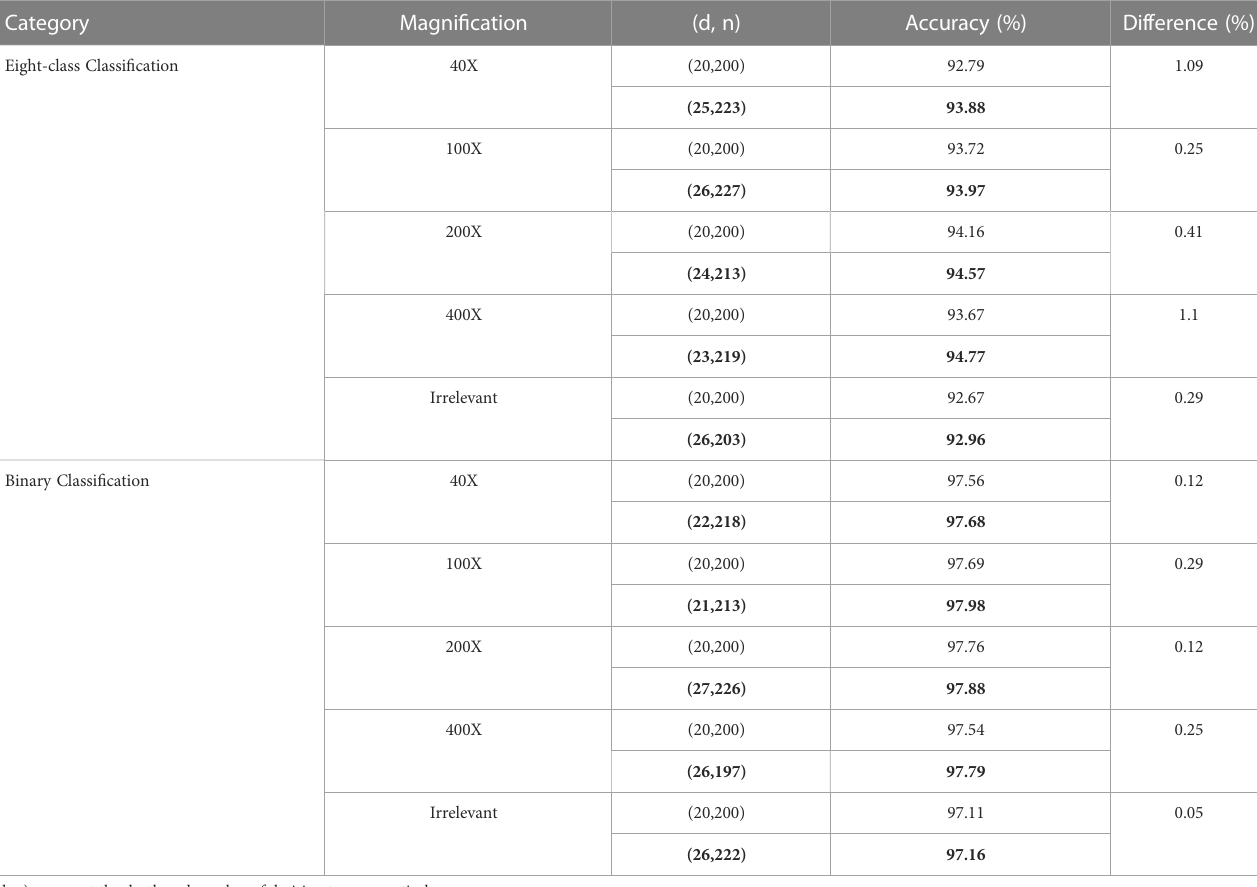
TABLE 6 Comparison of accuracy before and after GridSearchCV optimization of PGLCM-SARF model.